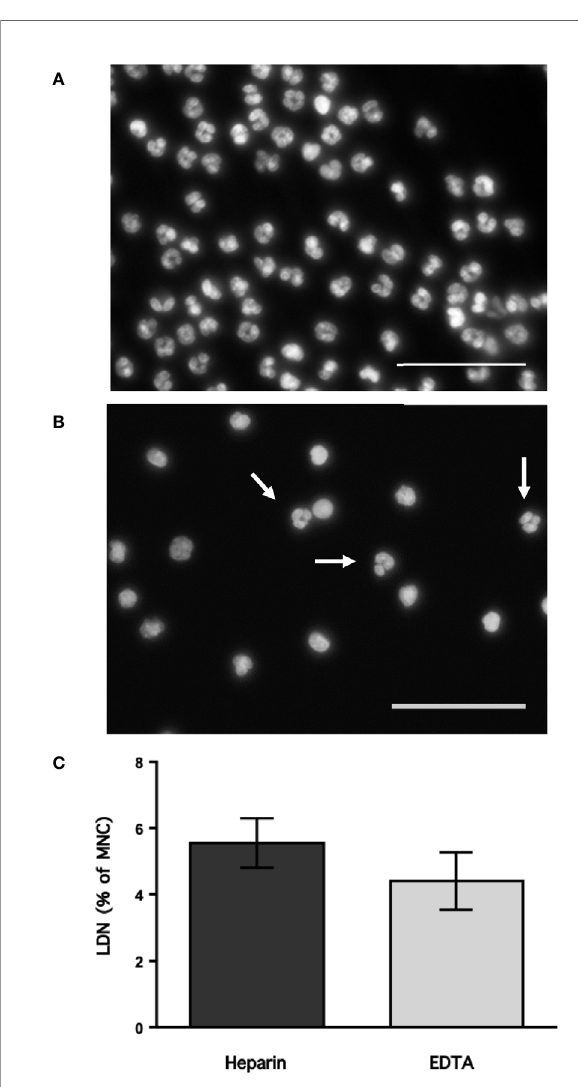
FIGURE 2 | Low-density neutrophils have a mature neutrophil morphology. Blood from young healthy donors was anticoagulated with heparin or with EDTA before leukocytes were separated by density gradient centrifugation into neutrophils (A) and mononuclear cells (B) , and then staining with DAPI to visualize only DNA (nuclei) by fl uorescence microscopy. Neutrophils (A) have typical multilobulated nuclei, while among MNC (B) several cells with the same nuclear morphology (white arrows) could be detected. Images are representative of 5 experiments with similar results. Scale bar represents 50 µm. (C) Low-density neutrophils (LDN) within mononuclear cells (MNC) were quanti fi ed by fl ow cytometry. Data are Mean ± SEM of fi ve experiments. No difference (p = 0.347) was found between anticoagulants. ( Figure 6D ). Cell-sorted LDN ( Figure 6E ) or neutrophils ( Figure 6F ) were then stimulated by PMA. After four hours, both cell types have produced typical NET. No difference was noted between the time and amount of NET produced by either LDN ( Figure 6G ) or neutrophils ( Figure 6H ).